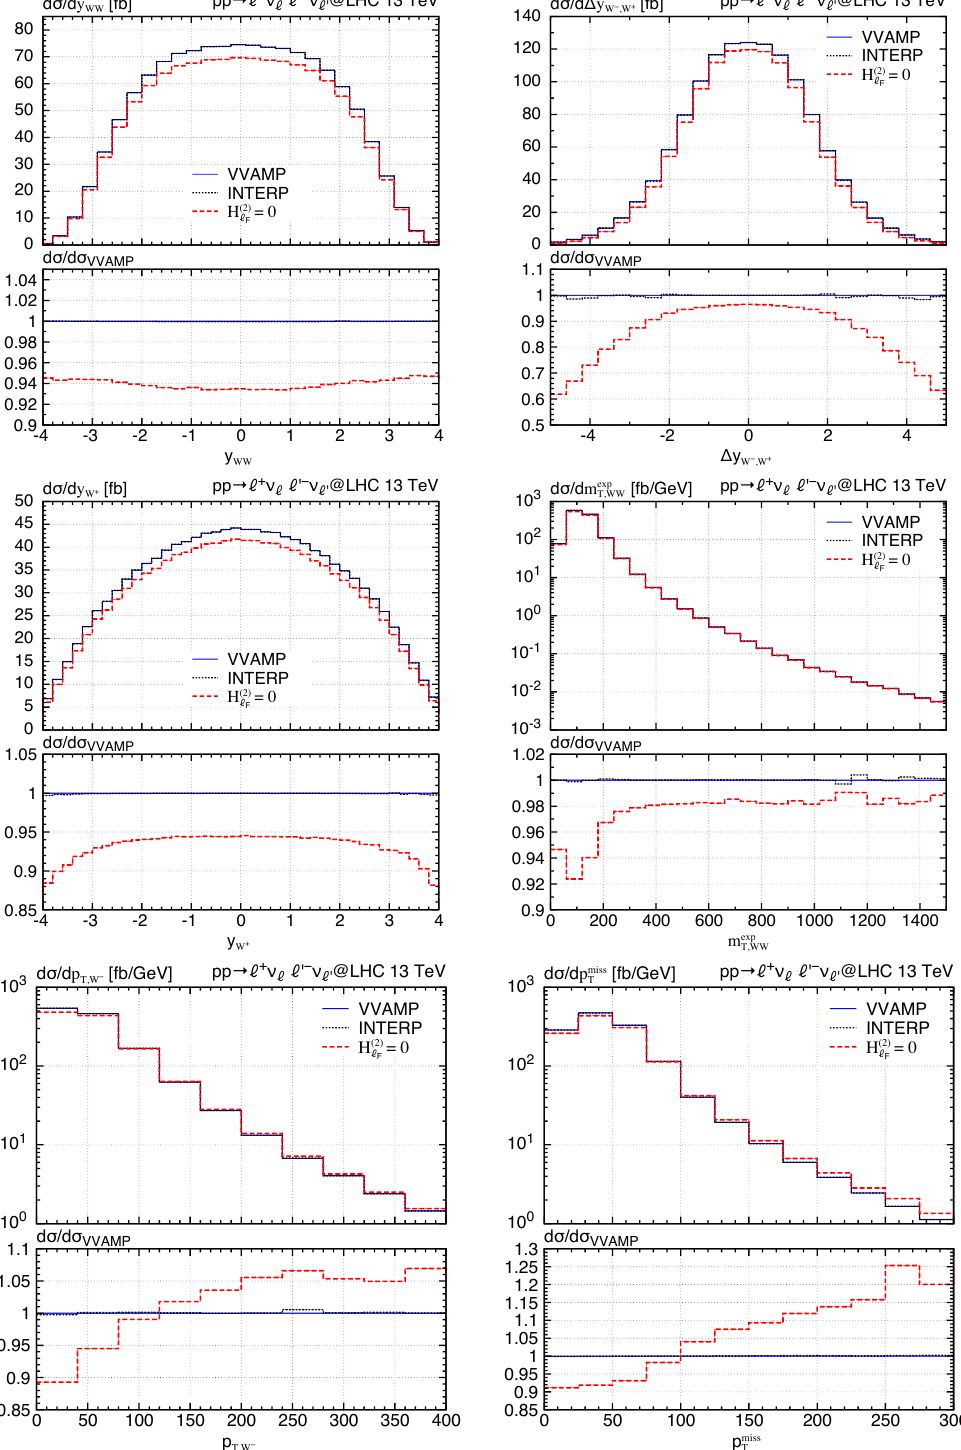
, (cid:1) y , WW W (cid:0) ;W +